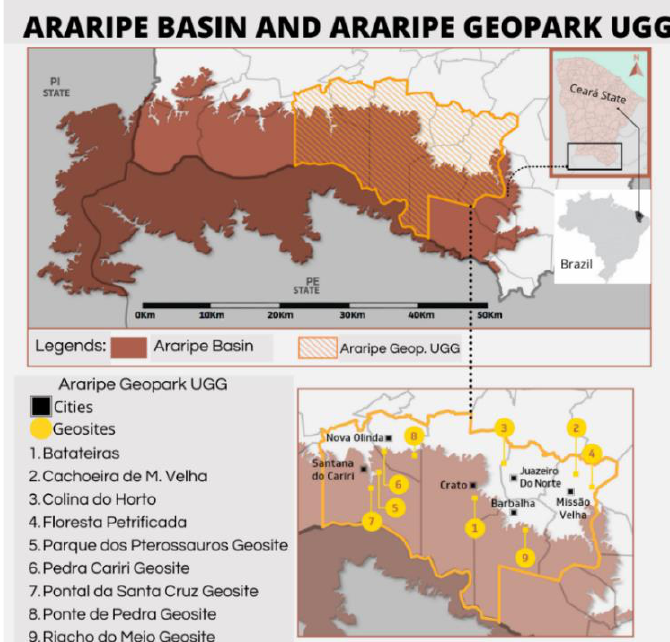
Figure 1. Map of the Territory and Geosites of Araripe UGG. Source: Research Collection.